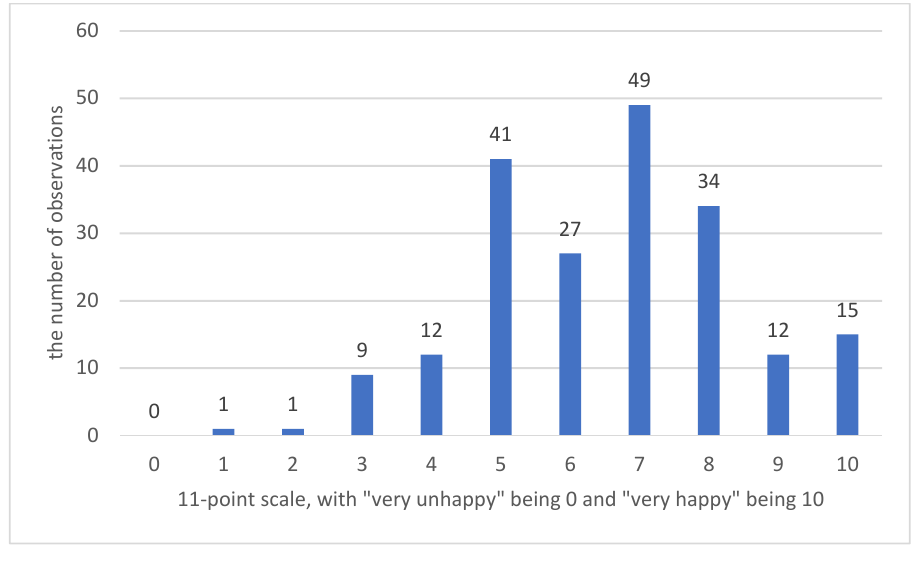
Figure 9. Distribution by subjective well-being. Well-being was measured on an 11-point scale, from “very unhappy” (0) to “very happy” (10).